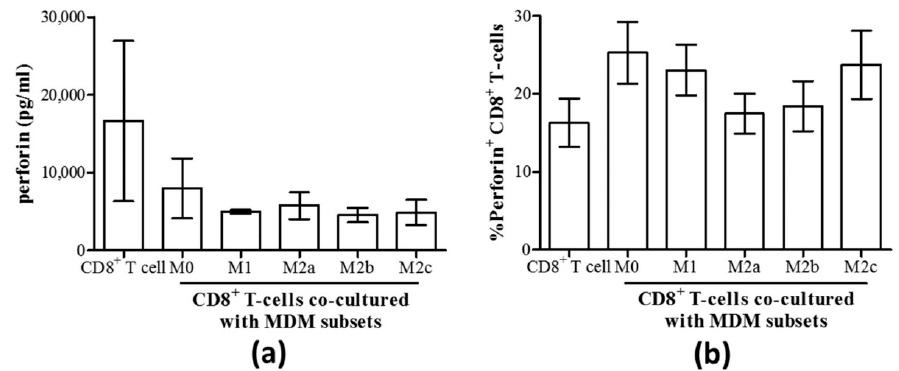
Figure 5. Perforin production by CD8 + T-cells remained unaffected by the co-culture with any macrophage subset. ( a ) The concentration of perforin released into culture supernatants of isolated autologous CD8 + T-cells cultured with MDM subsets for 48 h was quantified by an immunobead assay (n = 3). ( b ) The proportion of perforin + CD8 + T-cells in co-cultures with macrophage subsets is shown (n = 7).